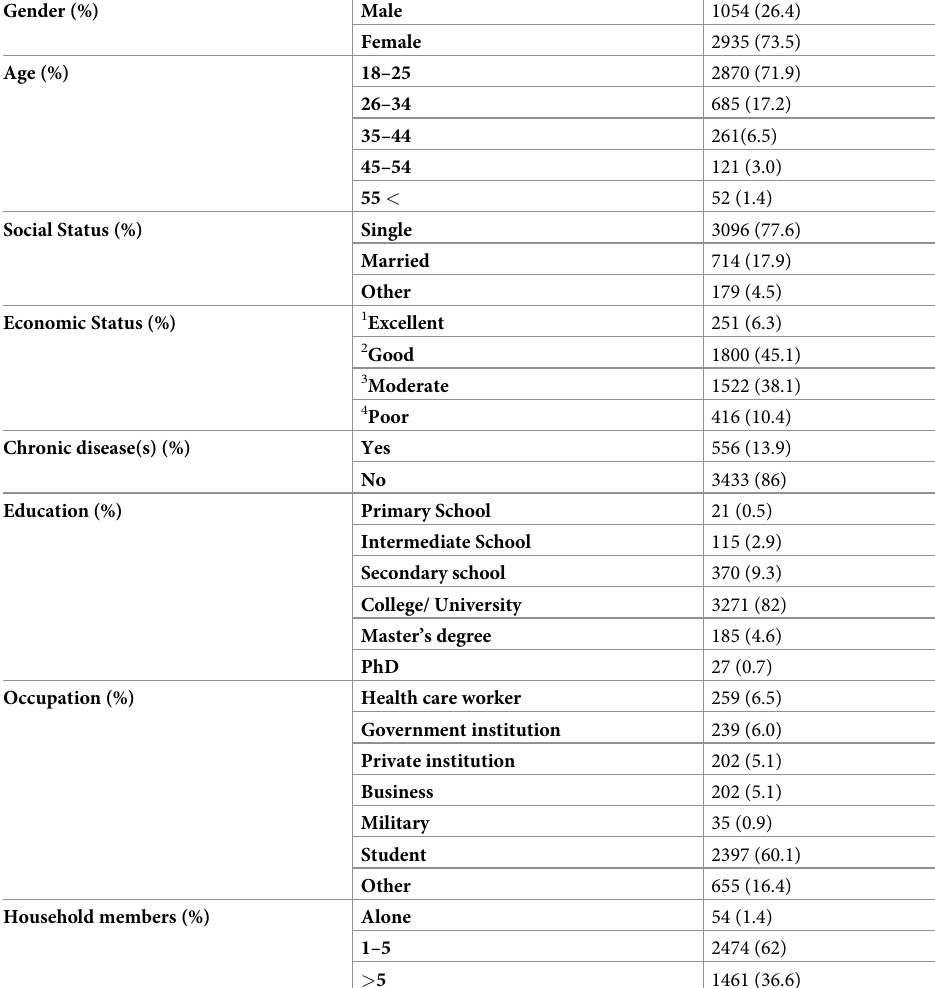
Table 1. Participants